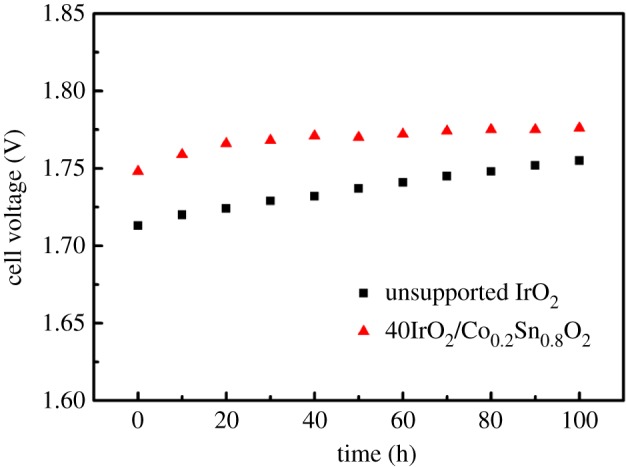
Durability test of the unsupported IrO2 and 40IrO2/Co0.2Sn0.8O2 sample in a single cell at 1 A cm−2 at 80°C.